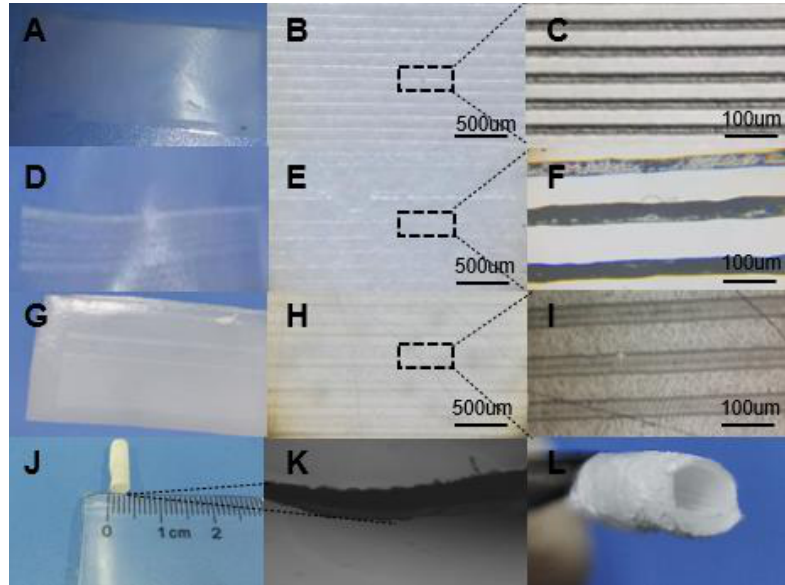
Figure 2. Artificial blood vessel size and film structure: ( A ) is the PPDO imprinting group film structure prepared by imprinting with the pdms chip containing microstructures at 120 ◦ C for 30 min at 120 ◦ C. ( B , C ) is the imprinting group film at different magnifications. The microstructure diagram under the microscope ( D ) is a sample film composed of PPDO base film and PCL direct writing structure imprinted with a pdms chip that does not contain microstructures in an imprinting machine at 120 ◦ C for 30 min. The temperature is 40 ◦ C, and the printing time is 30 min. ( E , F ) is the microstructure of the PCL direct-write composite film under different magnification